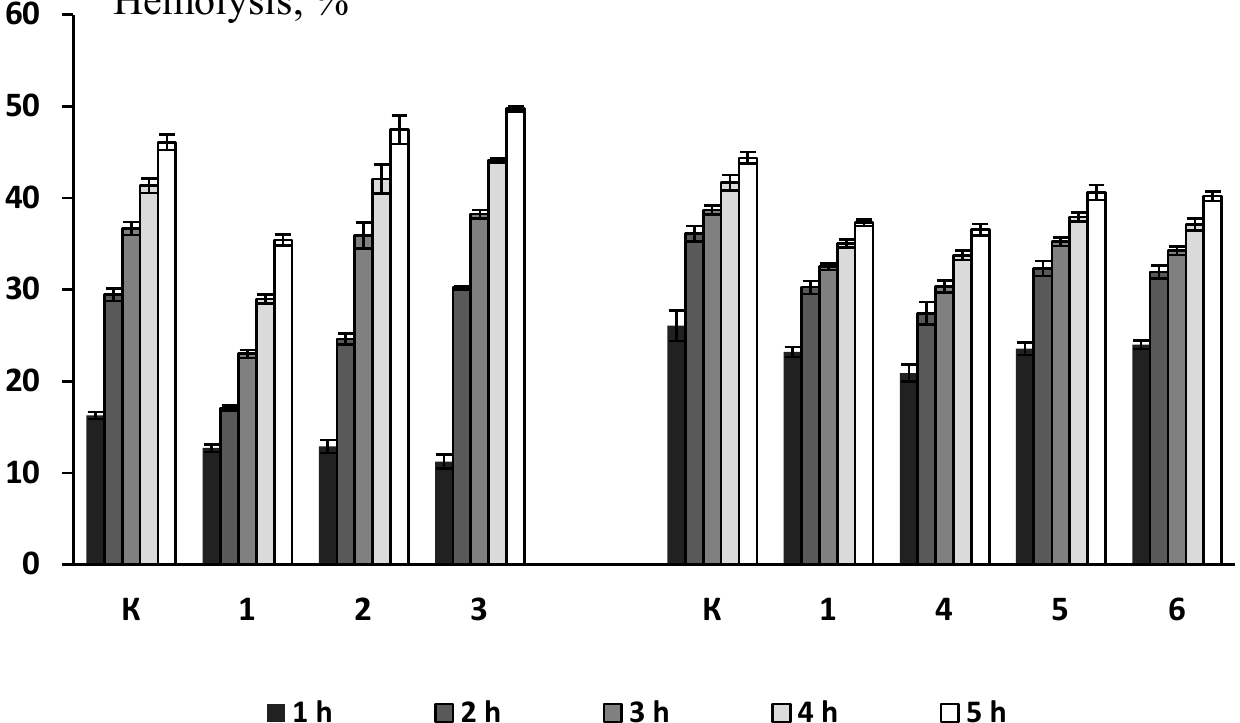
Figure 6. The influence of compounds 1–6 (100 µ M) on the level of H 2 O 2 -induced erythrocyte hemolysis after 1–5 h of incubation. Vertical bars: means ± SE ( n = 3–6).